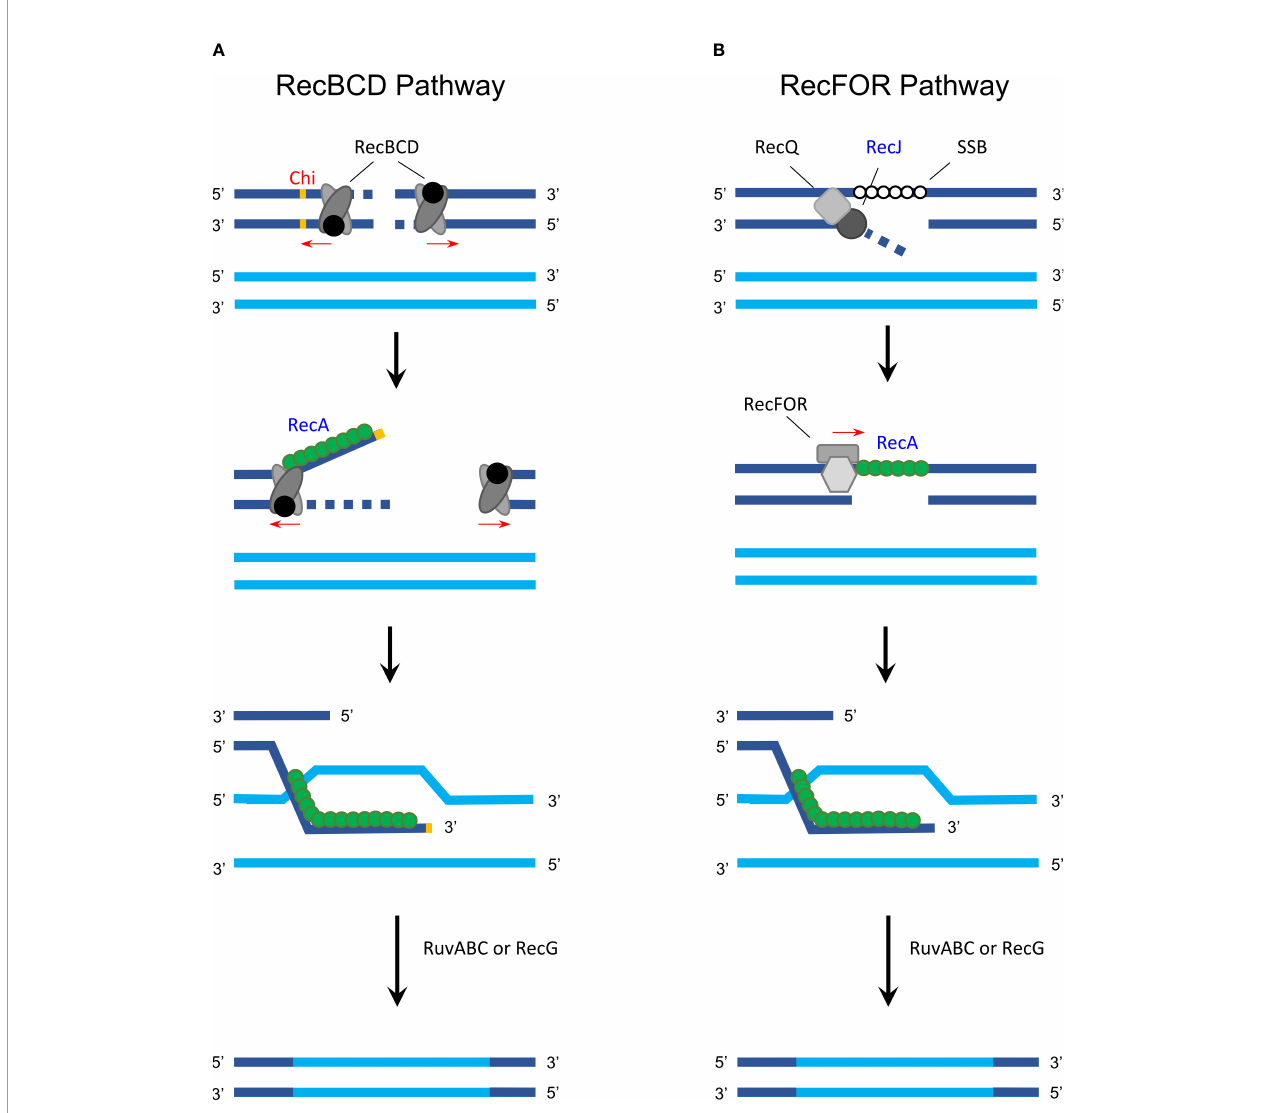
FIGURE 1 | Homologous recombination in gram-negative bacteria. (A) The RecBCD pathway is activated following a double-strand break that causes the RecBCD complex to bind on both ends and degrade DNA from the 3 ′ to 5 ′ end until one of the complexes encounters a Chi site. RecBCD then degrades the DNA from to 5 ′ to 3 ′ end while RecA (green) can bind to the 3 ′ extension. Next, the RecA-covered single-strand DNA invades a homologous sequence (synapsis formation) and RuvABC (with or without RecG) is used to resolve the Holliday junction, exchanging DNA via recombination. (B) In the RecFOR pathway, a single-strand break is fi rst unwound with helicase RecQ and degraded with RecJ, while single-stranded binding protein (SSB) attaches to the exposed strand. This is followed by RecFOR promoting the replacement of SSB with RecA followed by the same process as described in the RecBCD pathway. Proteins that were analyzed in detail regarding its function and activity in Chlamydia are labeled in blue; protein/sites that are unknown or inexistent in Chlamydia are labeled in red. The fi gure was modi fi ed from Rocha et al. (2005), Figure 1, and Snyder et al. (2013), Figures 10.2, 10.3, and